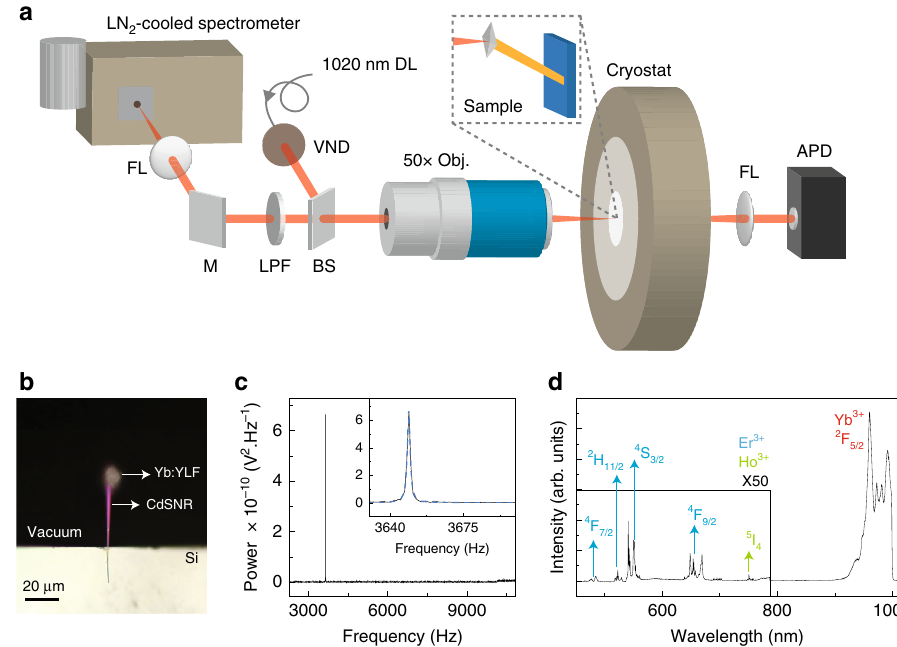
Fig. 1 Experimental setup. a The schematic of the eigenfrequency and up-converted fl uorescence measurement setup. FL, M, SPF, DL, BS, VND, and APD stand for focusing lens, mirror, 1000 nm short-pass fi lter, diode laser, beamsplitter, variable neutral density fi lter, and avalanche photodiode, respectively. b A bright- fi eld optical image of the CdSNR cantilever supported using a silicon substrate with a Yb 3 + :YLF crystal placed at the free end. c A peak in the thermomechanical noise spectrum originating from the fundamental eigenfrequency of the CdSNR with Yb 3 + :YLF sample obtained at the 0.04 MWcm − 2 at 300 K. d A stitched, up-converted fl uorescence spectrum obtained at room temperature using a 1020-nm excitation source (0.04 MW cm − 2 ) focused on the suspended Yb 3 + :YLF crystal. A 1000-nm short-pass fi lter was used to cut off the laser